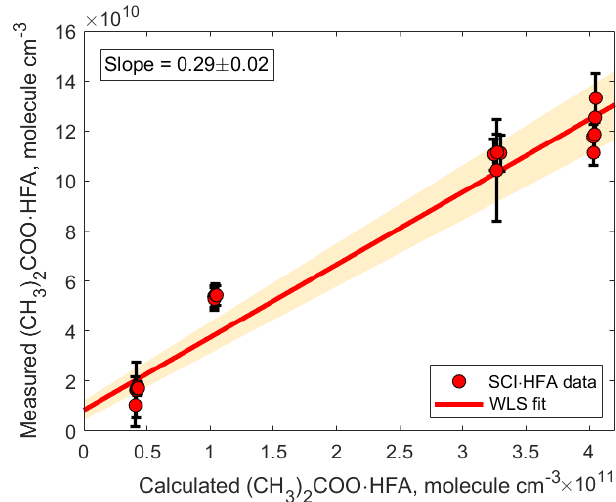
Figure 4. Correlation plot comparing measured and calculated con- (cid:113) centrations of ( CH 3 ) 2 COO HFA. The adducts were detected us- (cid:113) (cid:113) ing H 3 O + CIMS as ( CH 3 ) 2 COO HFA H + ( m/z 241.03). The slope was calculated using weighted least squares (WLS). The 95% confidence interval was estimated via a Monte Carlo simulation ( N = 5000) and is shown using red